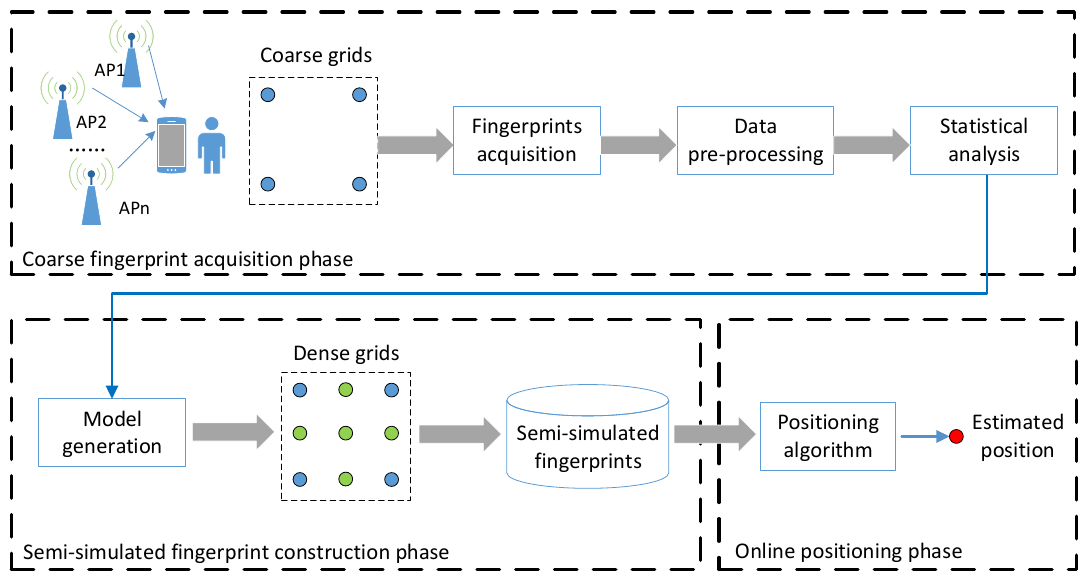
Figure 1. Architecture of the proposed Semi-simulated RSS Fingerprinting (SS-RSS) method, with the blue “o” denoting the site-surveying grids of real-world measurements, and the green “o” for the non-site-surveying grids with simulated Received Signal Strength ( RSS ) values.